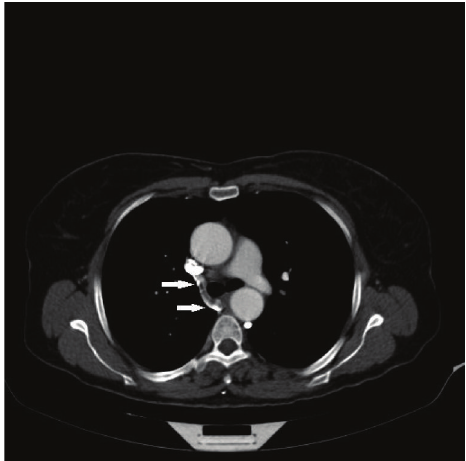
Figure 5: The left azygos vein was poured to left subclavian vein (arrow).